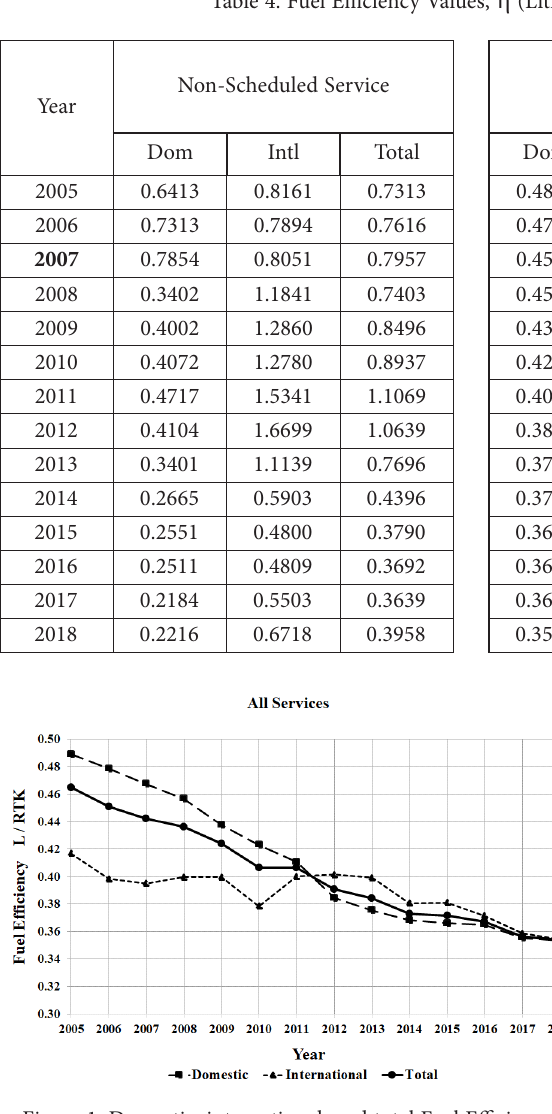
Figure 1. Domestic, international, and total Fuel Efficiency Values η (L/RTK) for all U.S. air carriers on an annual